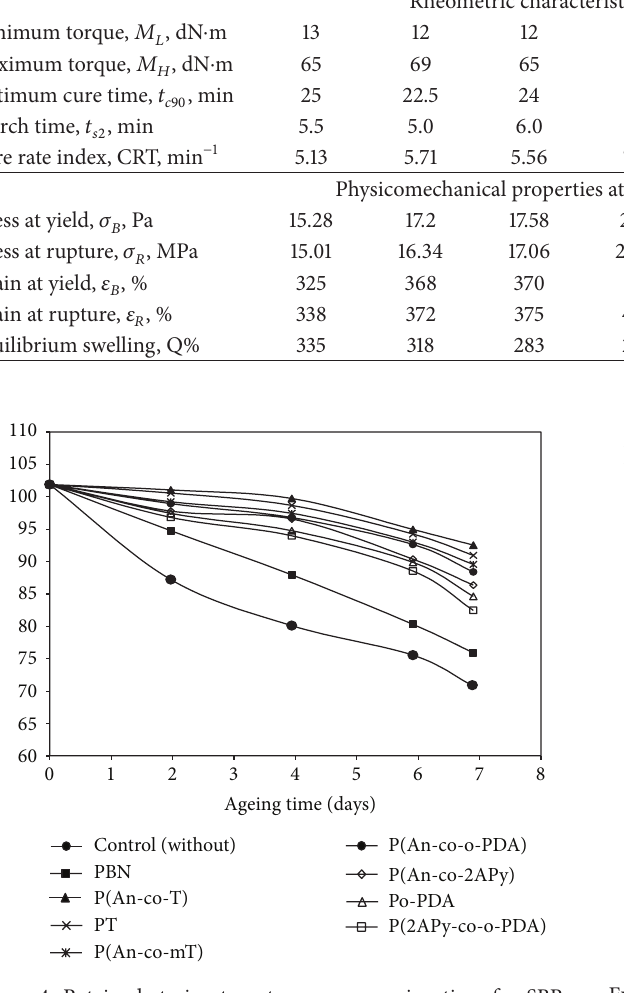
Figure 4: Retained strain at rupture versus ageing time for SBR vulcanizates.